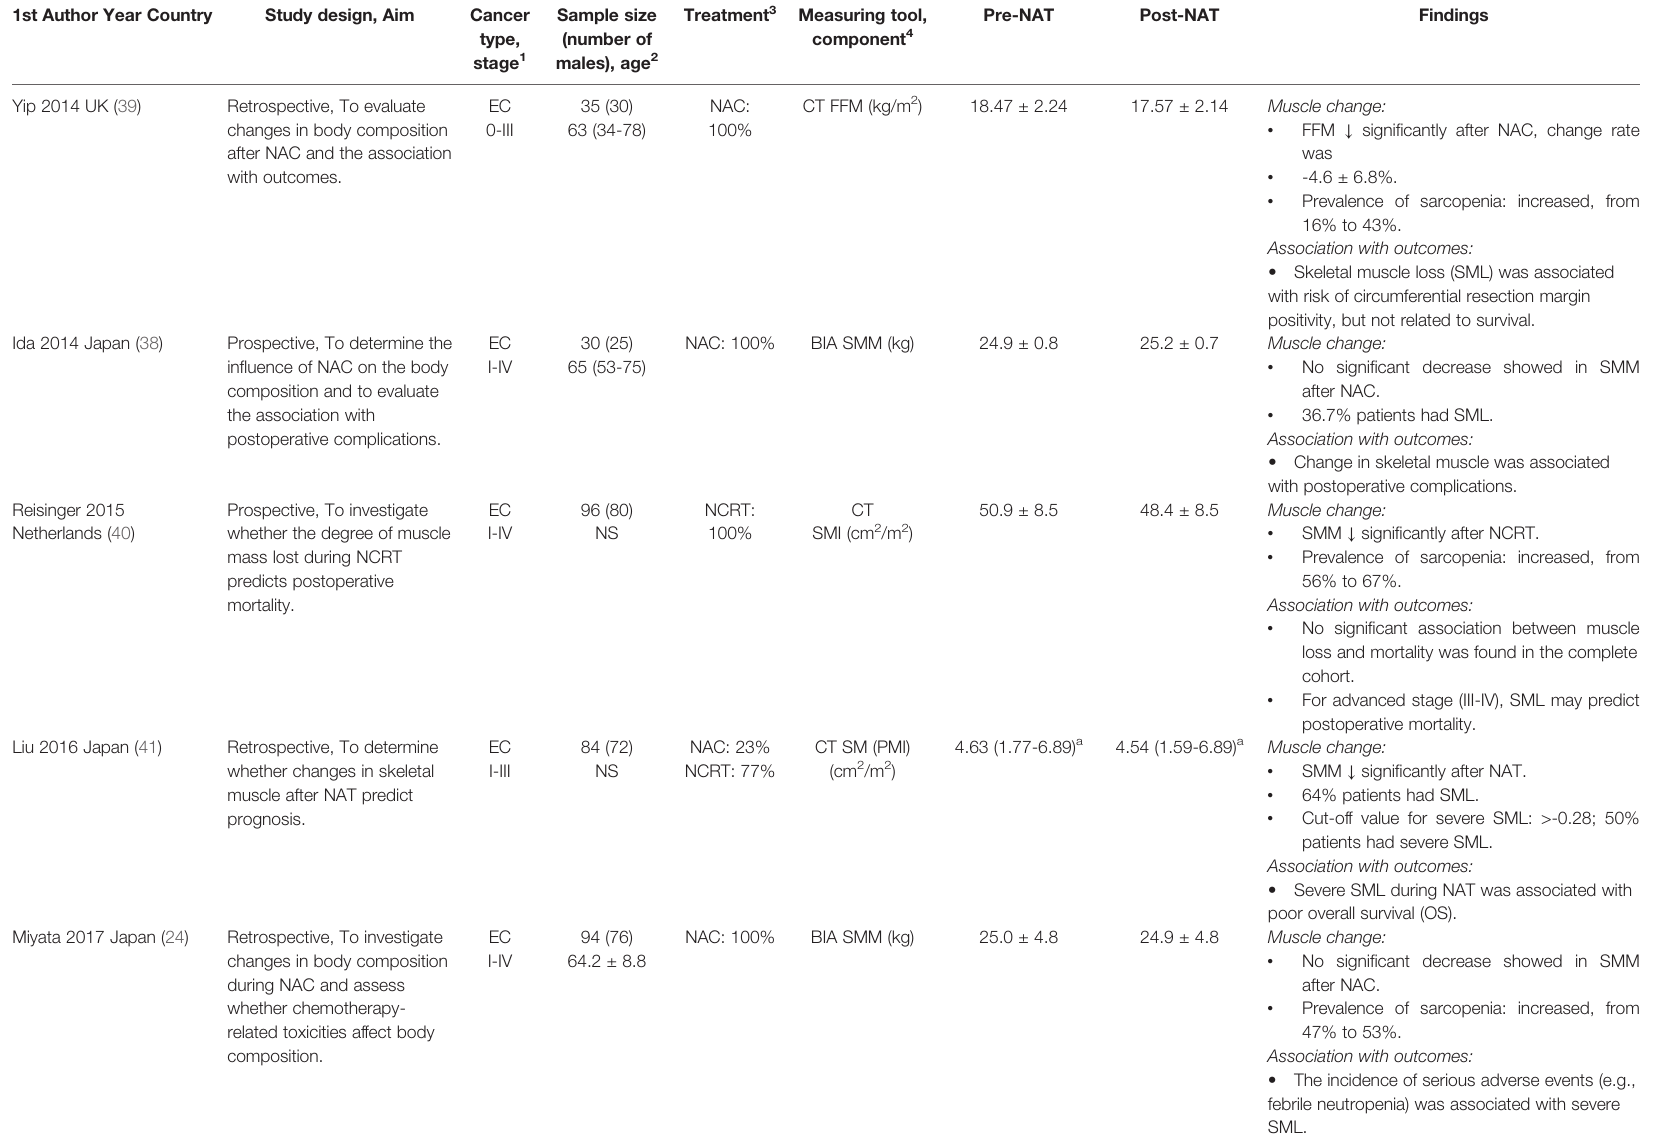
TABLE 2 | Main characteristics of included studies (n =